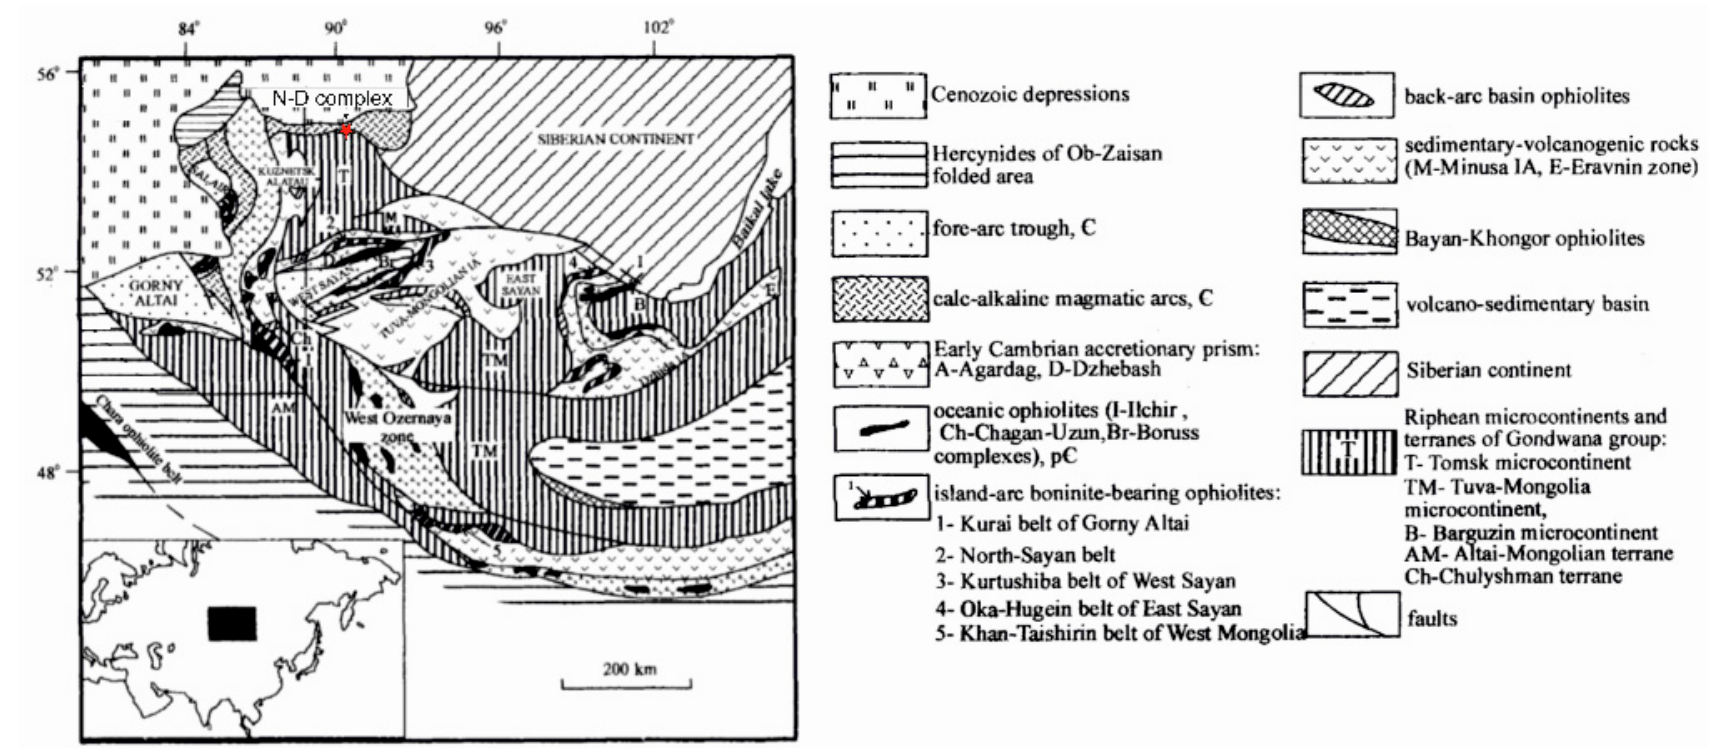
Figure 1. Geologic map of the Nizhne-Derbinsk mafic-ultramafic complex [54]. IA = Island Arc system (Tuva-Mongolian IA, Dzhida IA, Munisa IA).